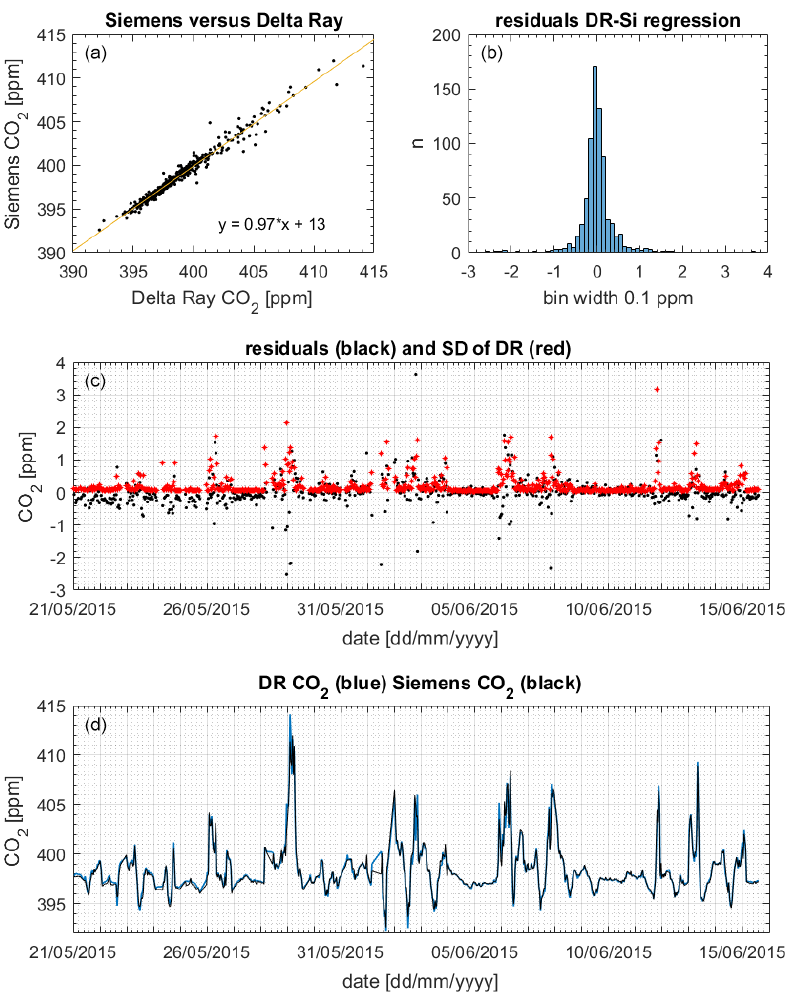
Figure 12. (a) Slope and scatter of the regression Siemens (Si) versus Delta Ray (DR). (b) Histogram of residuals. (c) Residuals (black) and 1 standard deviation (1 σ ) of the DR measurements (red). (d) CO 2 mole fractions from DR (blue) and Siemens